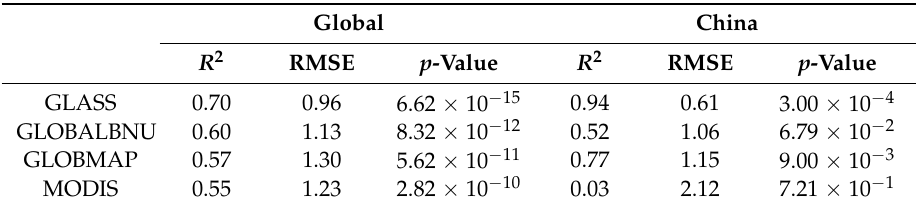
Table 3. Validation indictors of four products. Global